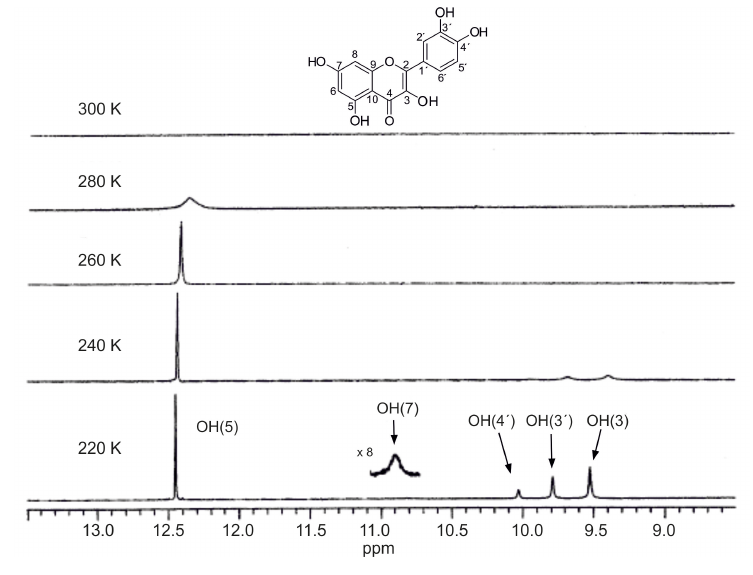
Figure 3. Variable temperature 400 MHz 1 H-NMR spectra of quercetin in CD concentration 10 mM. Reproduced with permission from [20]. Copyright 2002, by Elsevier Science Ltd. (Amsterdam, The